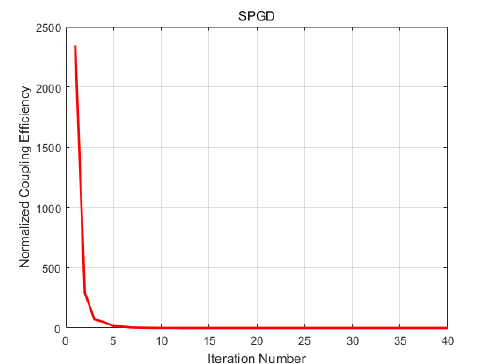
Figure 12. The variation trend of cost function of